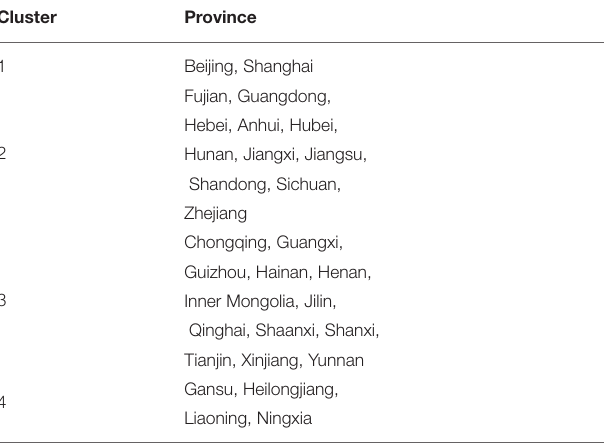
TABLE 4 | The optimal clustering by